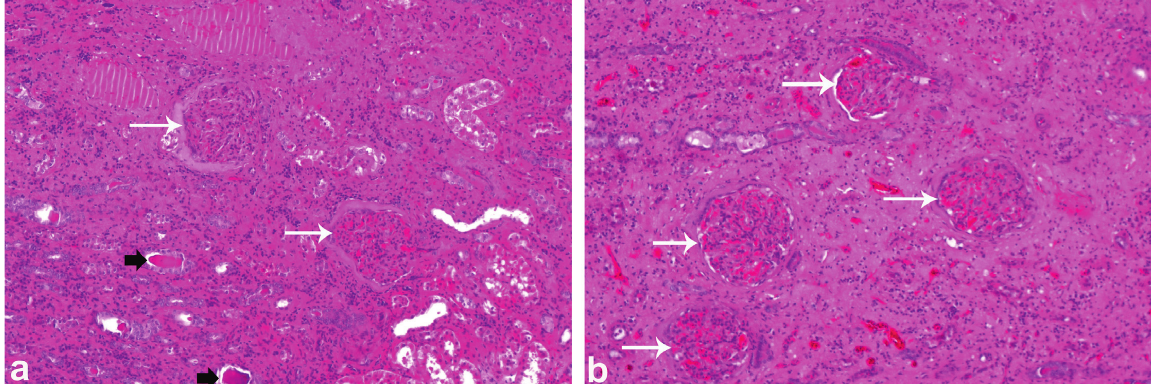
Figure 16: Histopathological findings of renal specimen of the right (a) and left (b) kidney in a camel with bilateral chronic active pyelonephritis showing renal cortical and medullary tissue with congested glomeruli (white arrows) and tubules with colloid casts and a fibrous and granulation tissue part at the periphery (black arrows). The interstitial tissue shows active and chronic cells infiltrate (H & E, × 100)